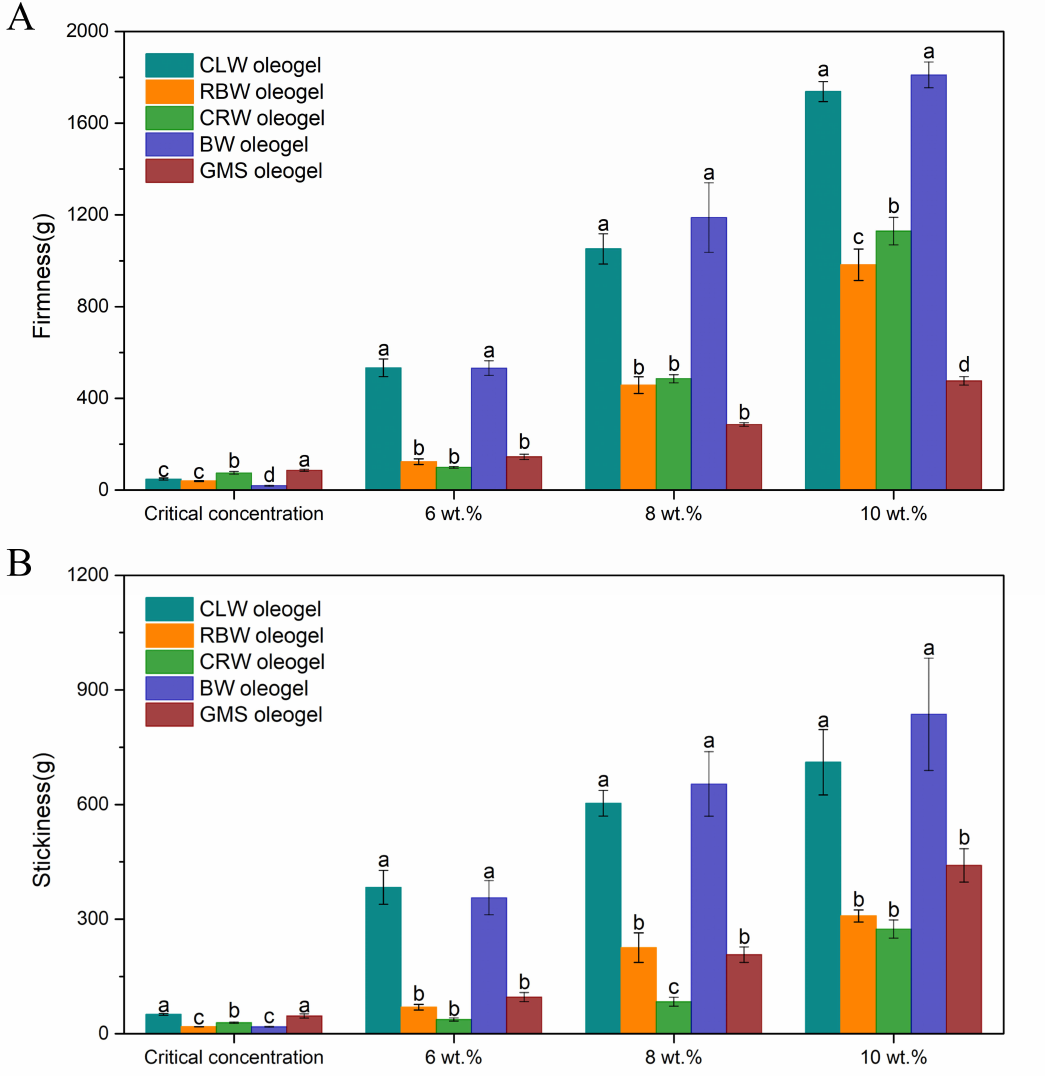
Figure 3. Firmness ( A ) and stickiness ( B ) of the oleogels at room temperature (~25 ◦ C). Sample preparation and analyses were performed in triplicate, and the results were expressed as mean with error bar. Different letters represent statistical differences between values within each panel ( p <